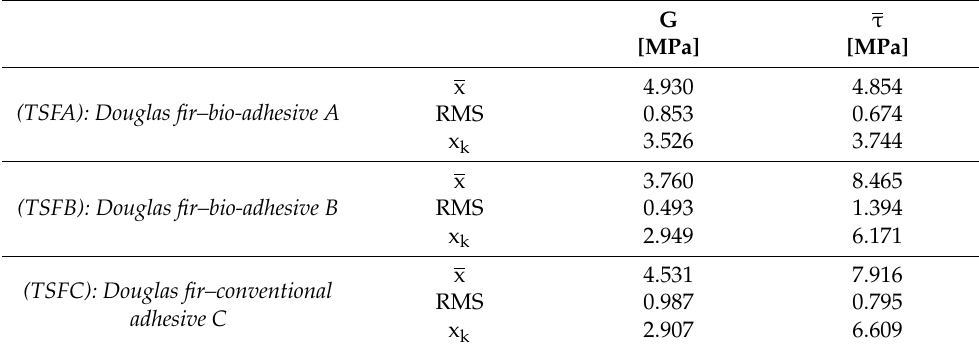
Table 6. Results for Douglas fir lap joint shear properties by tensile loading.